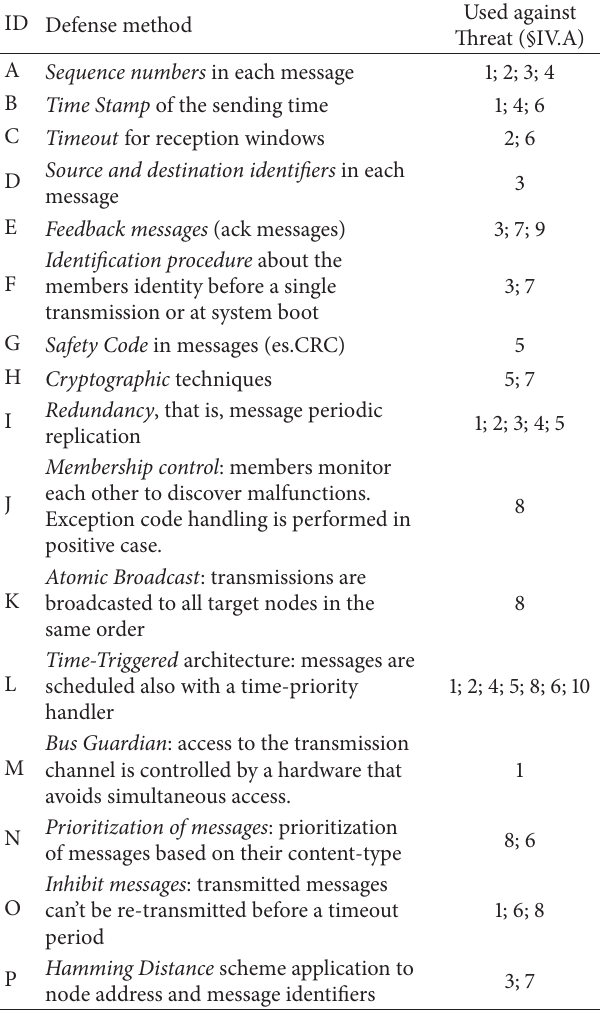
Table 2: Description of defense methods against